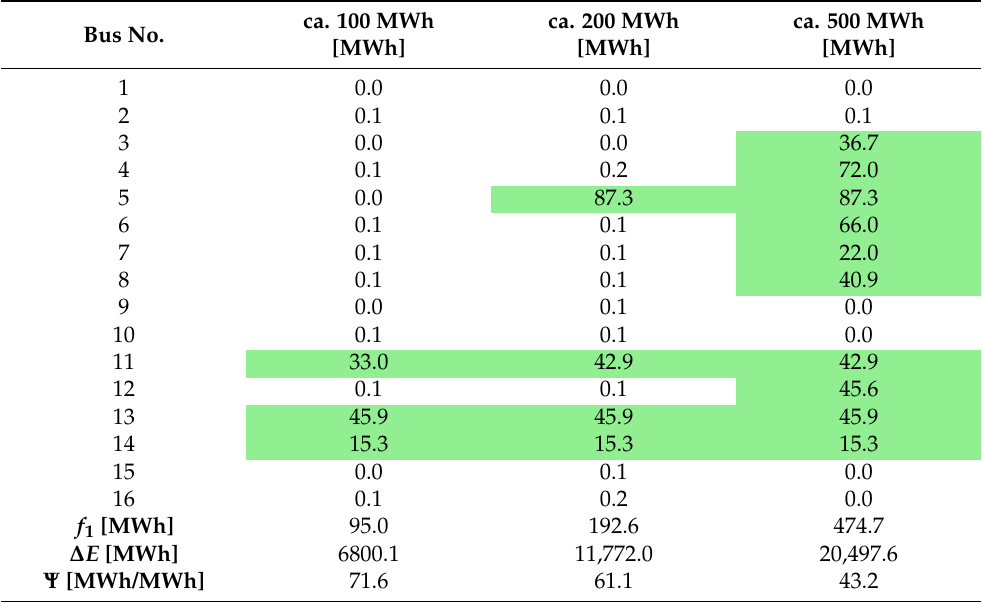
Table 7. Three solutions founded by pa (cid:101) -BRKGA with ca. 100 MWh, 200 MWh and 500 MWh of overall BESS capacity for Test Case 4. Bus